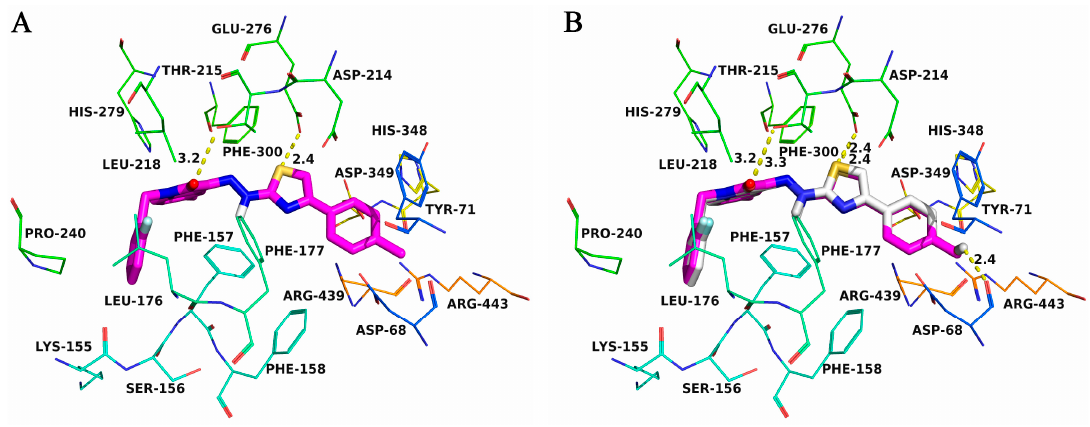
Figure 4. ( A ) Compound 6b was docked to the binding pocket of the Saccharomyces cerevisiae α -glucosidase. ( B ) Compounds 6b and 6p were docked to the binding pocket of the Saccharomyces cerevisiae α -glucosidase